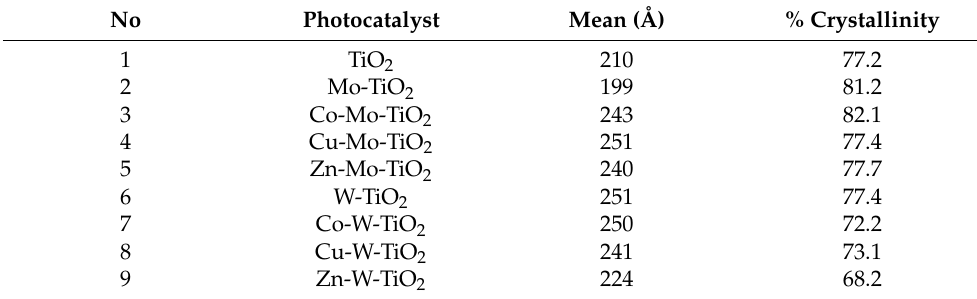
Table 1. Mean particle diameter and crystallinity of the photocatalysts.